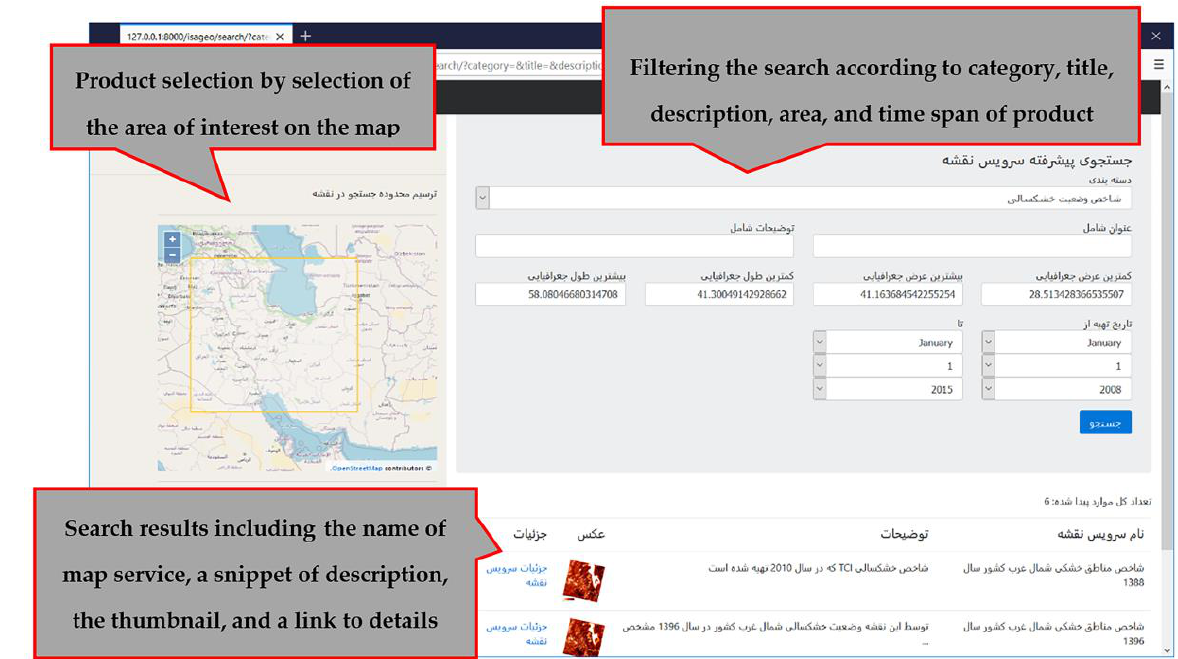
ISPRS Int. J. Geo-Inf. 2021 , 10 , x FOR PEER REVIEW